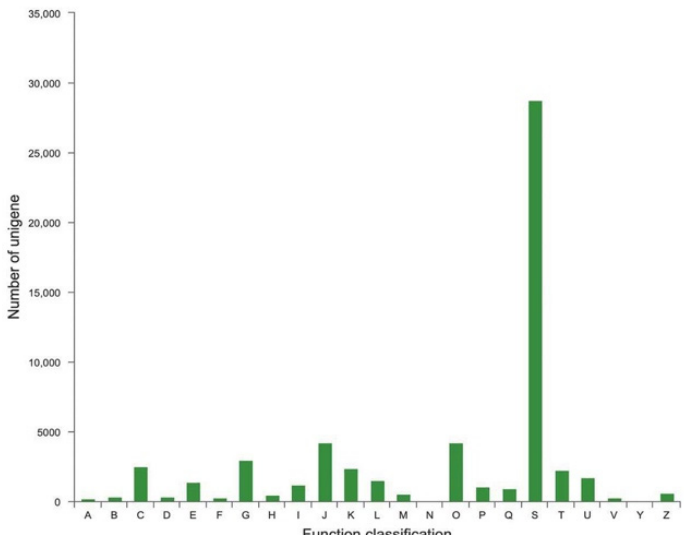
Figure 5. COG classification of unigenes. A: RNA processing and modification; B: Chromatin structure and dynamics; C: Energy production and conversion; D: Cell cycle control, cell division, chromosome partitioning; E: Amino acid transport and metabolism; F: Nucleotide transport